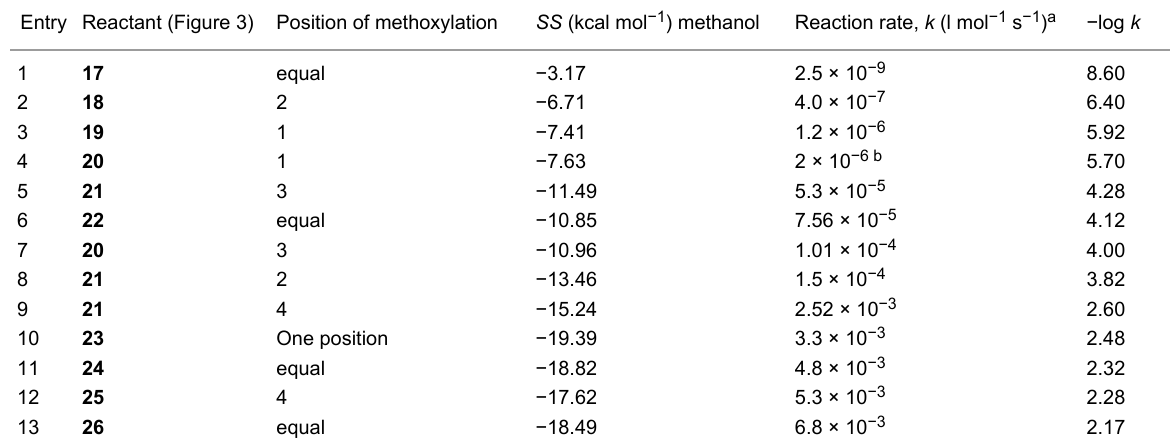
Table 3: Series C. Sigma stability ( SS ), experimental rate constants [19] and negative logarithms for experimental rate constants ( − log k ) for the reac- tion between sodium methoxide with different chlorofluorobenzene reactants in methanol at 50 °C. The structures of the reactants are shown in Figure